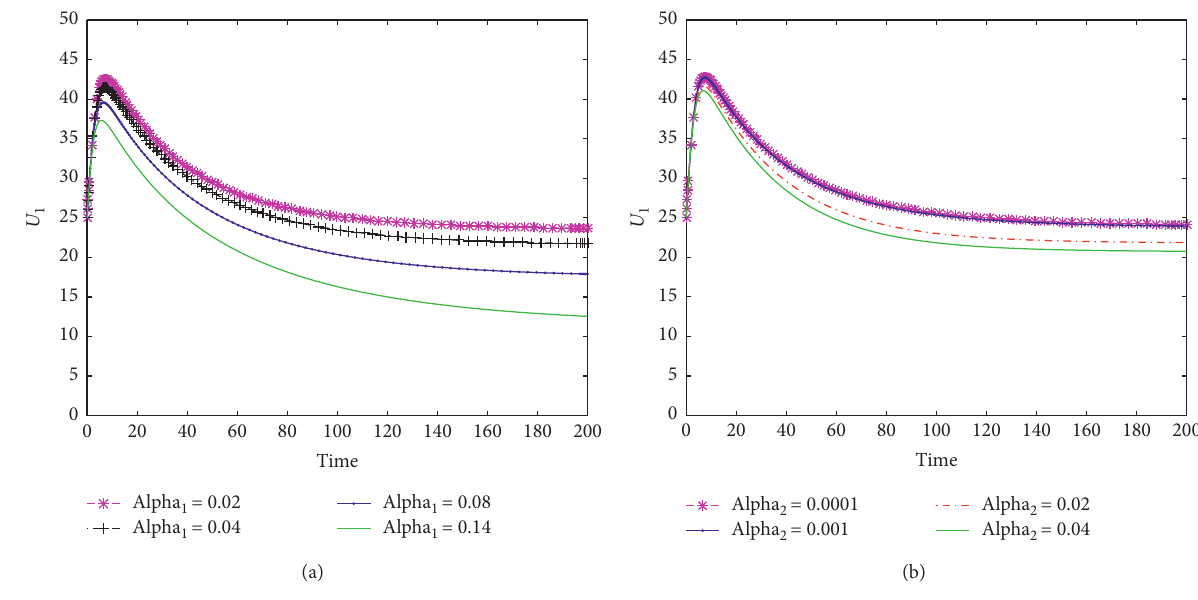
Figure 6: Effect of (a) α